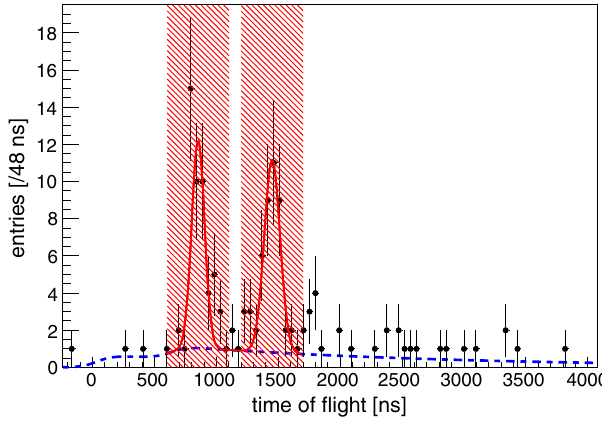
FIG. 10. TOF distribution after the application of pulse-height cut. The events in the hatched (red) bands were used for bunch width measurement.